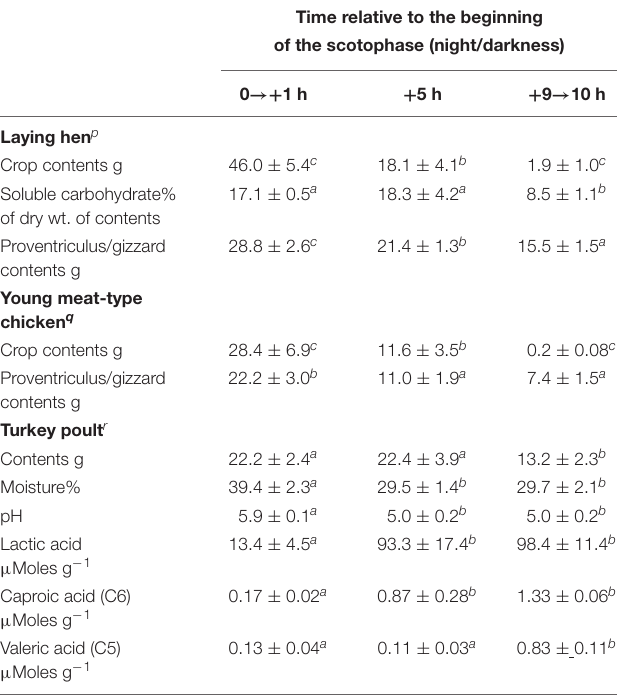
TABLE 3 | Changes in the crop attributes during the scotophase. TABLE 4 | Proportion of individual VFAs generated in the ceca of chickens.